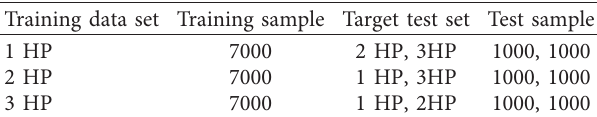
Table 4: Variable load adaptive data